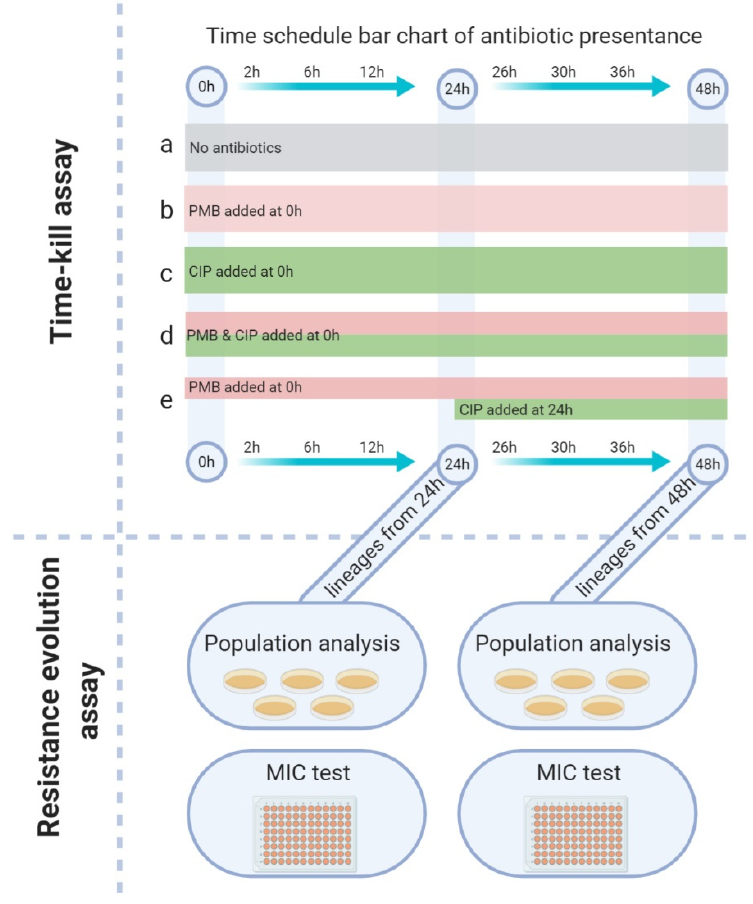
Figure 1. Graphic representation of the in vitro microbiology study. Colored bars in the time schedule represent different addition times and durations of spray–dried antibiotic dry powder application; the group codes correspond to Table 3. Lineages from different time–kill assay (at 24 and 48 h) groups were used for further assaying resistance development.